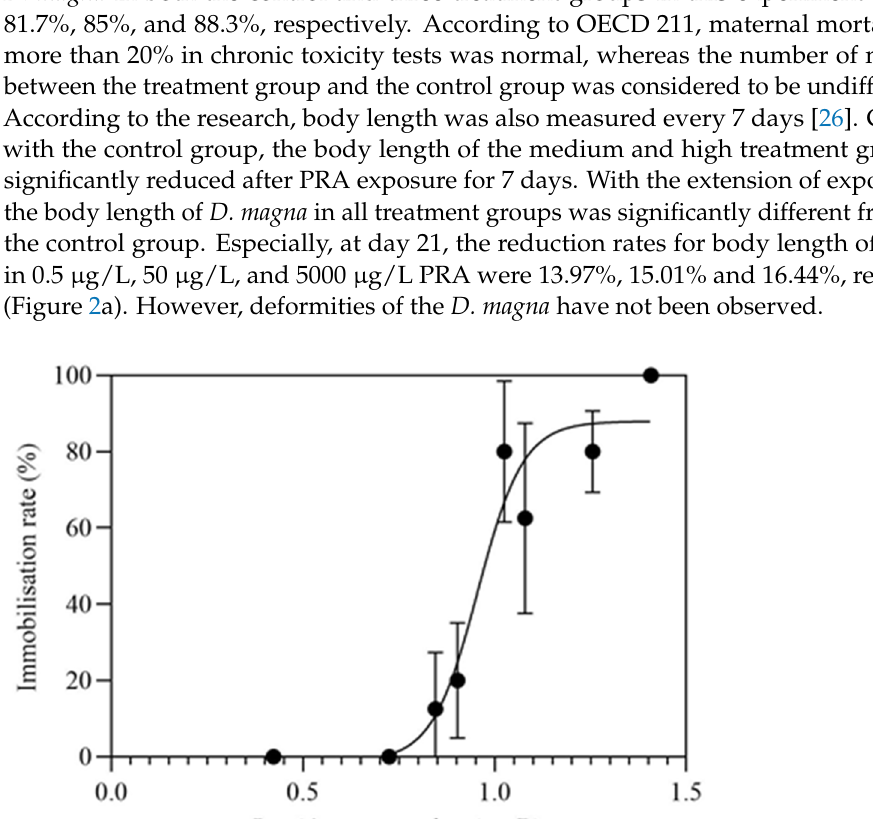
Figure 2. Growth parameters in D. magna after 21 d exposure to pravastatin sodium (PRA): ( a ) Body length growth in D. magna during 21 d test; ( b ) Offspring per each clutch in D. magna during 21d PRA exposure test; ( c ) The average number of reproduction (left) and molting (right) of each D. magna during 21 d PRA test. C, L, M and H represent the control, low, medium and high PRA treat- ment groups, respectively. An asterisk (*) indicates that the parameters of PRA treatment groups are significantly different from control ( p < 0.05; n = 60). 3.2. Transcriptome Analysis 3.2.1. Sequence Assembly and Generation There were 43,726,361, 43,431,852, 40,943,921 and 39,705,239 raw reads obtained in the control, low, medium and high treatment groups, respectively. Moreover, the Q20 per each sample was above 96.8%. After trimming and quality checking, 40,869,750,